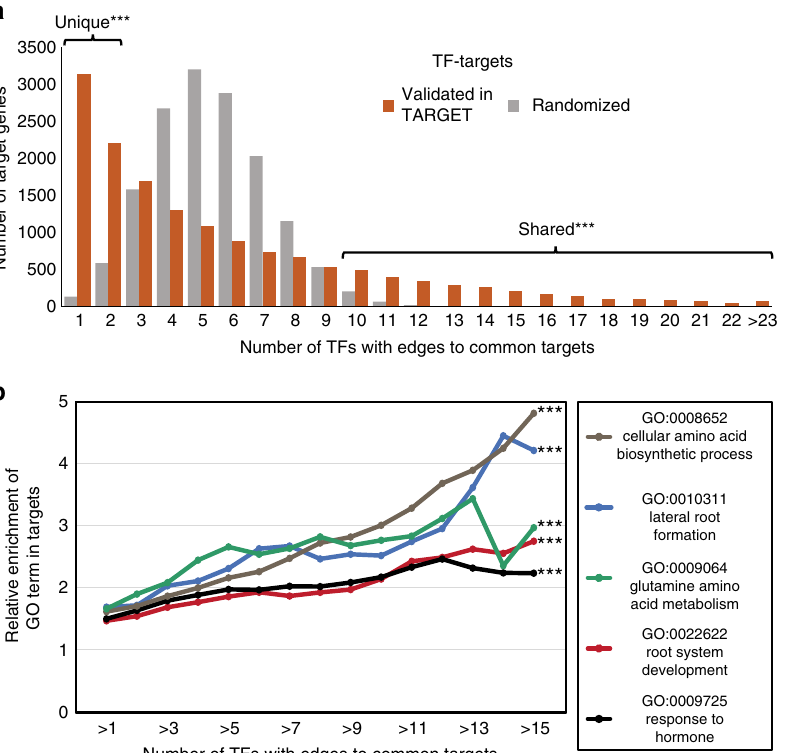
Fig. 3 Nitrogen (N)-early response transcription factors (TFs) coordinate a connected network of N-related genes. a TF – target edges identi fi ed by TARGET (Transient Assay Reporting Genome-wide Effects of Transcription factors) in root cells for the 33 N-early response TFs were used to construct a validated network (orange bars). This validated TF – target network resembles a scale-free distribution, with signi fi cantly more unique targets (edges to 1 or 2 TFs) or shared targets (edges to 10 or more TFs), compared to a network which contains the same TFs and targets but with randomized edges (gray bars) ( n = 1000). b Enrichment of gene ontology (GO) terms for N-related processes increases as the number of TFs regulating the set of target genes increases. Signi fi cance was tested by calculating a fi gure of merit, called Focus, for the validated TF – target network and comparing it to the Focus values of randomized networks ( n = 1000) in which the edges within the validated network were shuf fl ed. (*** p value < 0.001, permutation test) (see Methods). Source data of Figs. 3a and 3b are provided as a Source Data fi